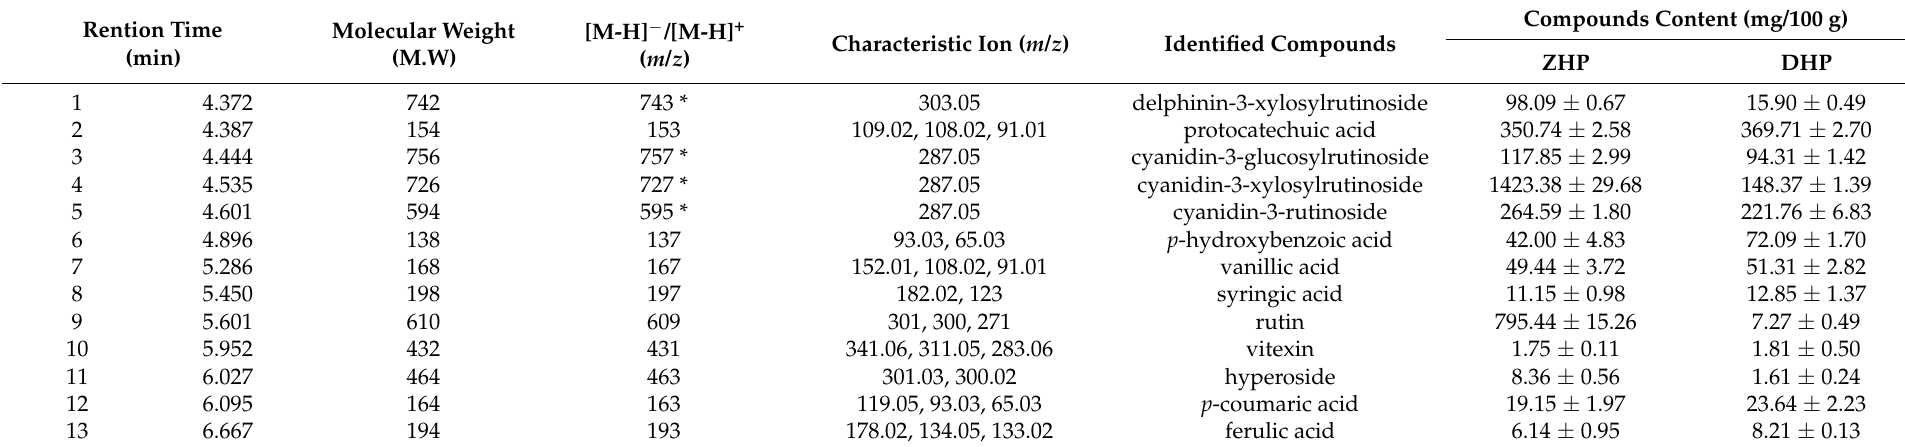
Table 2. Compositions and content of phenolic compounds from Kadsura coccinea epicarp tested by